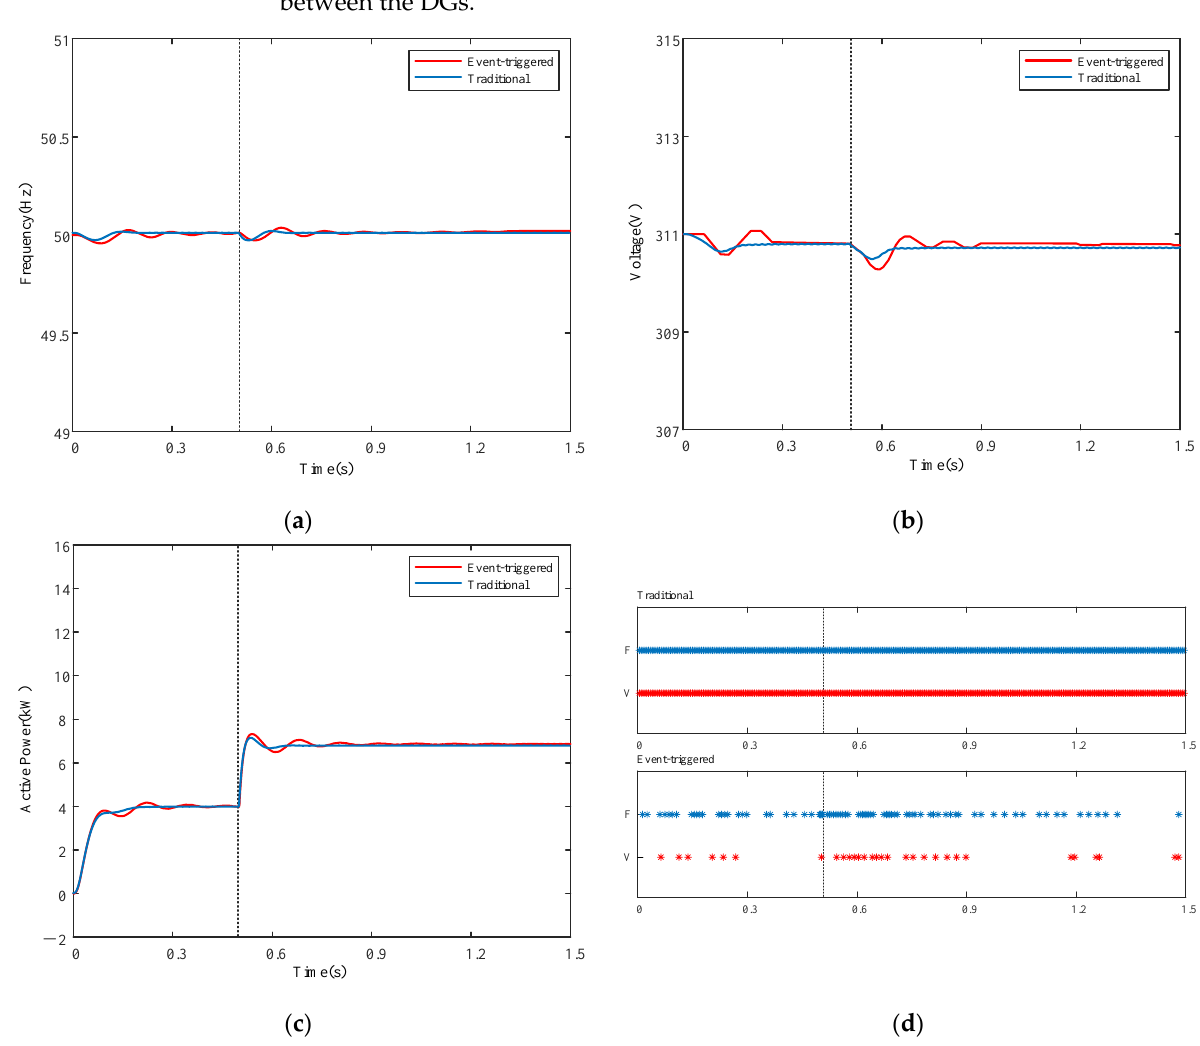
Figure 10. ( a ) Frequency output waveform of DG1; ( b ) voltage output waveform of DG1; ( c ) active power output waveform. ( d ) Trigger event instants for DG1. Table 2. Communication